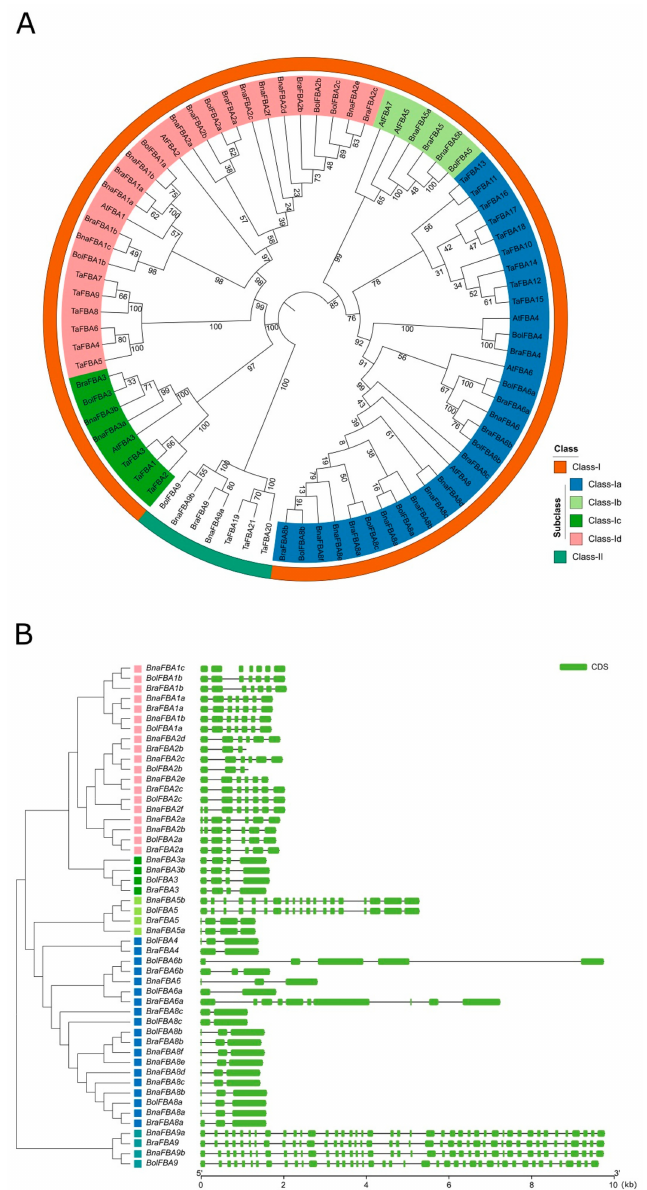
Figure 2. Phylogenetic relationships and gene structure of BnaFBA genes. ( A ) Phylogenetic relationships of BnaFBAs , BraFBAs , BolFBAs , AtFBAs, and TaFBAs . The unrooted tree was generated using MEGA7.1 software by the neighbor-joining method. The numbers next to the branch show the 1000 bootstrap replicates expressed in percentage. The phylogenetic classes of FBA genes were marked by corresponding colors that are shown in the color legend at the bottom right. ( B ) The schematic diagrams of the exon-intron organization of FBA genes in B. napus , B. rapa, and B. oleracea . The phylogenetic tree of the FBA genes is placed at the left, and the color squares represent phylogenetic classes. The green boxes and lines indicate CDS (coding sequence) and introns, respectively. The length of the scale is at the